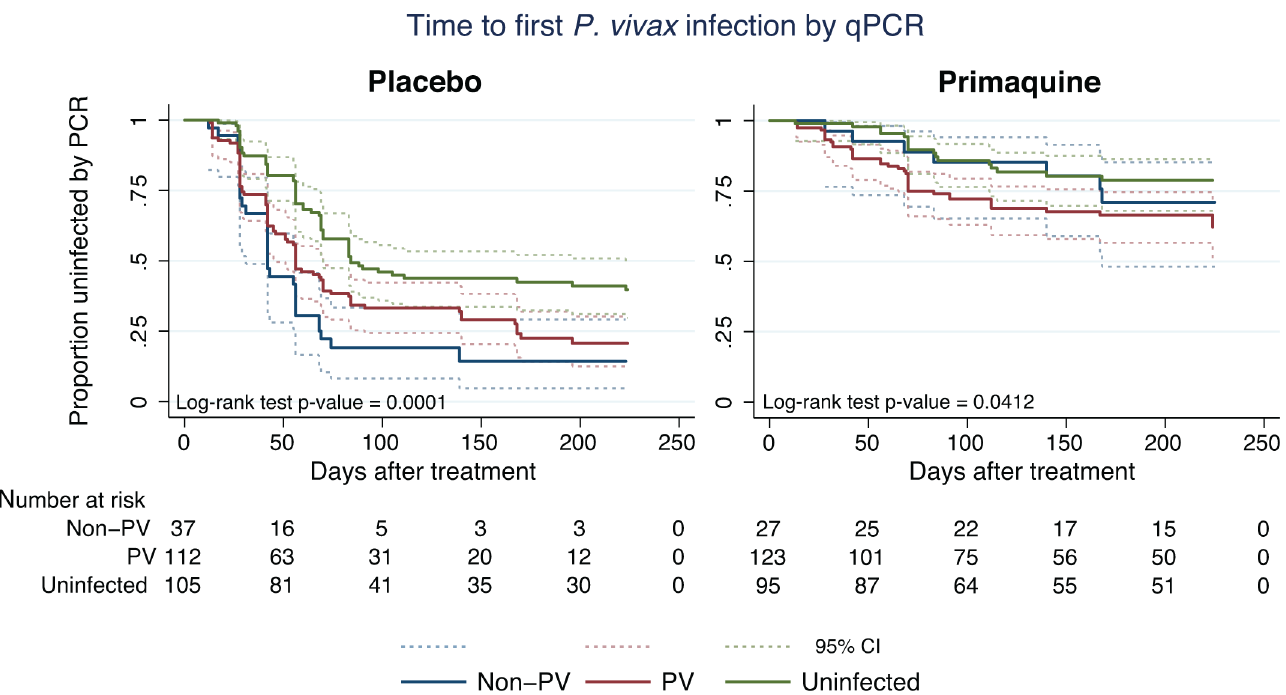
Fig 5. Kaplan-Meier plots showing the time to first (or only) P . vivax infection by qPCR in the PL and PQ arms, stratified by Plasmodium infection status at enrolment. Dashed lines represent the respective 95% confidence intervals. PV, P . vivax .